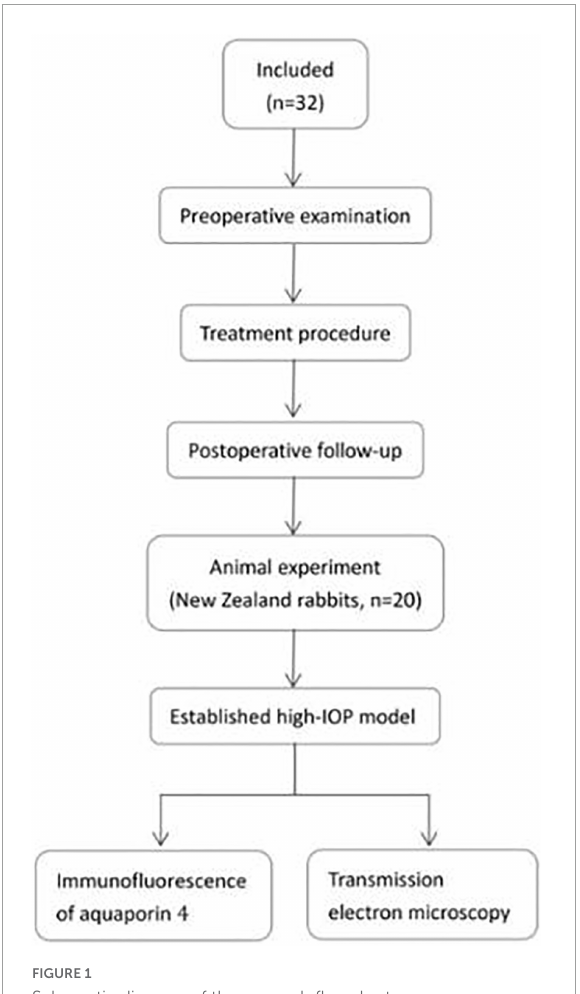
FIGURE1 Schematic diagram of the research